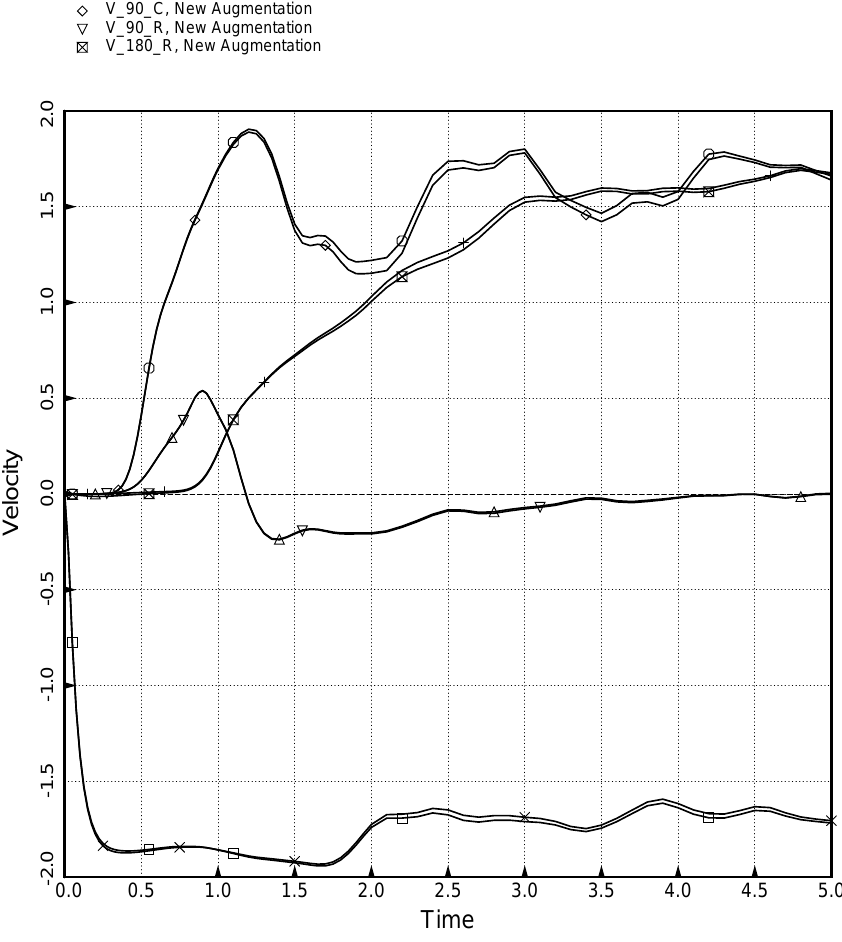
Fig. 4. Cylinder, DAA 2m, Singular mass in new